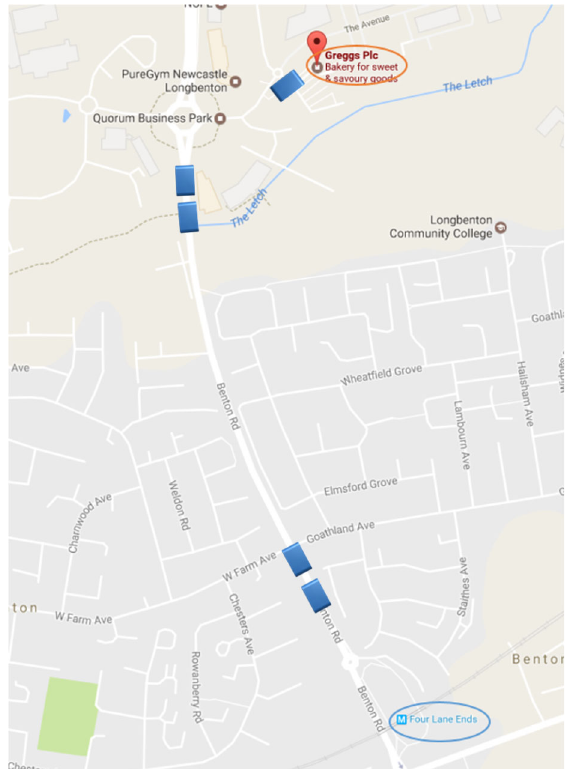
Fig. 24 Map showing location of Four Lane Ends metro